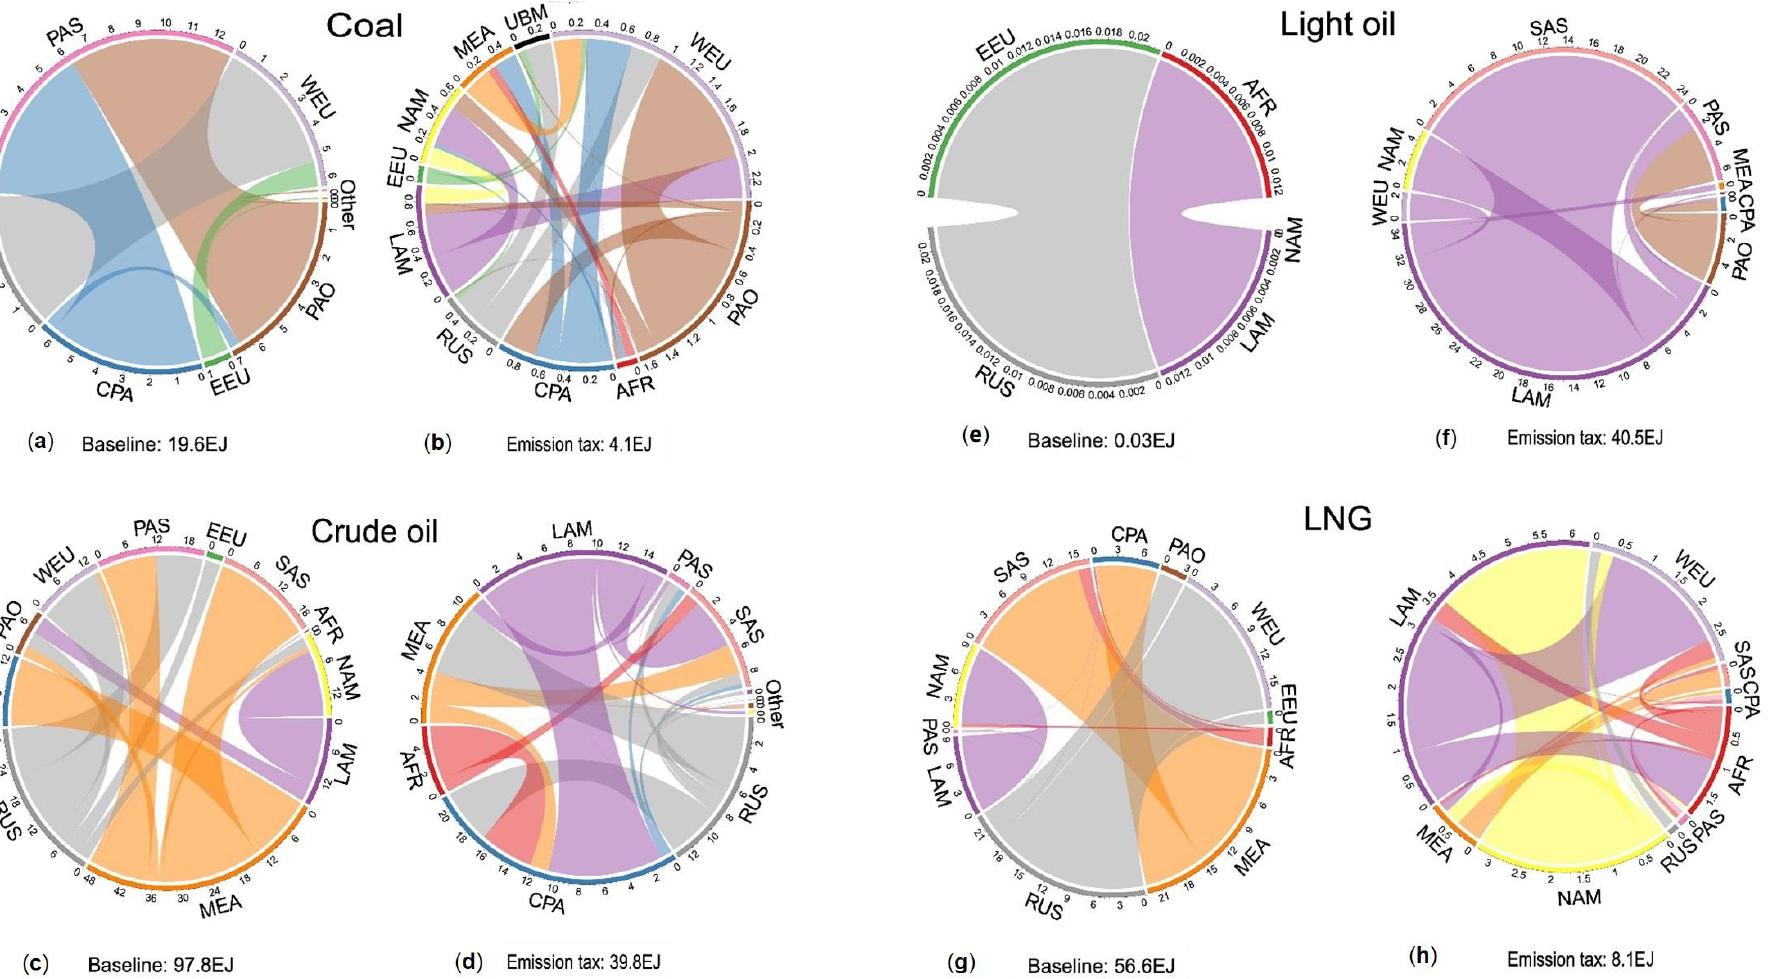
Figure 4. Trade networks in 2050 under the baseline scenario (left column) and emissions tax scenario (right column). ( a , b ) represent coal trade, ( c , d ) represent crude oil trade, ( e , f ) represent light oil trade, ( g , h ) represent LNG trade. Total trade for the given energy commodity is given in the corresponding box in EJ.